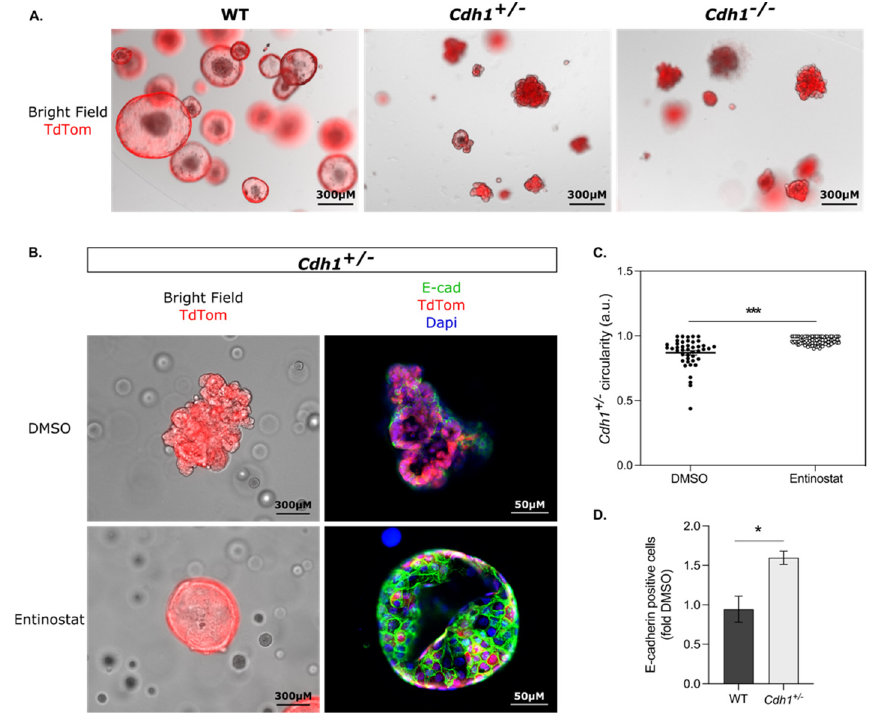
Figure 7. Entinostat increases E-cadherin expression in Cdh1 +/ − organoids, leading to rounded mor- phology. Cdh1 +/ − organoids were induced at day 1 followed by drugging at day2 with entinostat or DMSO for 48 h. ( A ) Bright field and tdTomato expression were assessed at day 4 in WT, Cdh1 +/ − and Cdh1 − / − organoids. Cdh1 decrease of expression was associated with a loss of circularity and the pres- ence of evagination. ( B ) Immunofluorescence was performed on Cdh1 +/ − organoids following 48 h of treatment with entinostat or its respective DMSO concentration. Bright field and tdTomato showed a maintenance of a circular morphology following entinostat treatment. Immunofluorescence on Cdh1 +/ − organoids was performed with E-cadherin stained in green, tdTomato in red and DAPI in blue for nuclear staining. A decrease of E-cadherin was observed after induction in the Cdh1 +/ − DMSO-treated organoids, whereas entinostat treated Cdh1 +/ − organoids maintained a strong E-cad- herin expression. ( C ) Circularity of the Cdh1 +/ − organoids was measured after DMSO or entinostat drugging, with a value of 1 representing a perfect circle ( n = 43–97 organoids analyzed). ( D ) E-cad- herin expression after entinostat drugging was measured by flow cytometry for WT and Cdh1 +/ − gastric organoids and normalized to their respective DMSO ( n = 4). Entinostat treatment increased the expression of E-cadherin in the Cdh1 +/ − organoids. Statistically significant results are labeled as * p < 0.05 and *** p < 0.001.